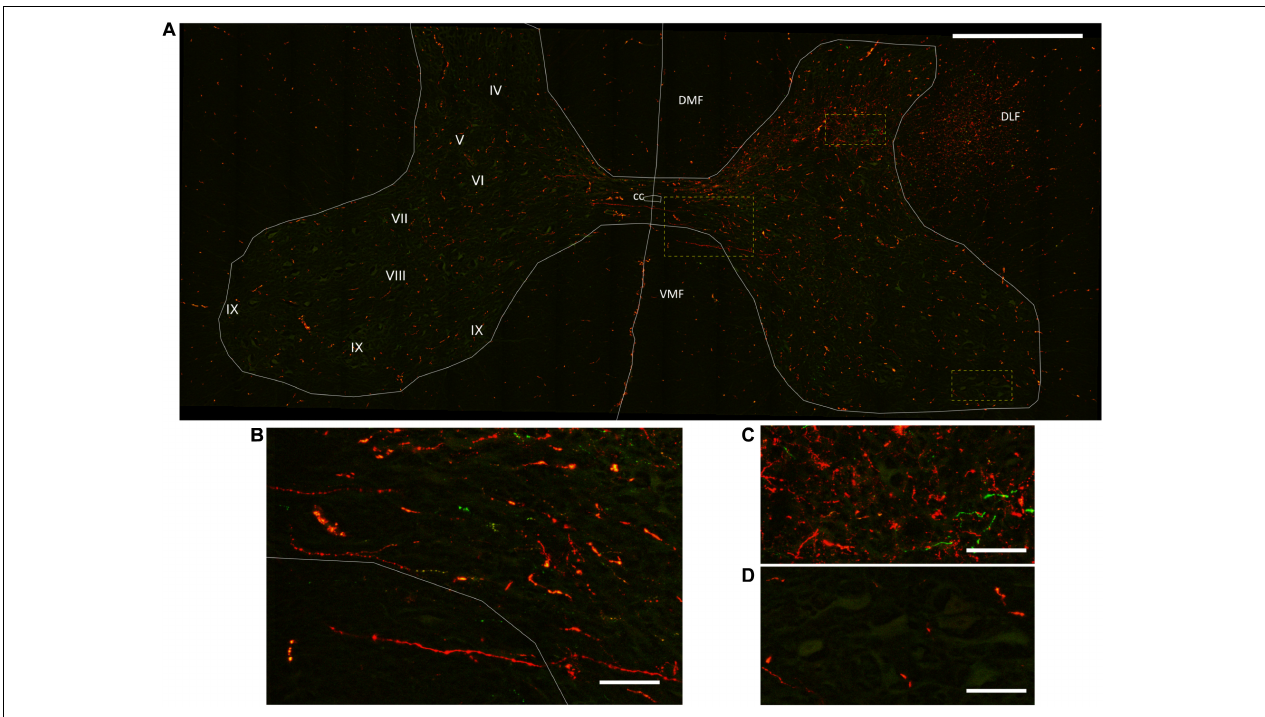
FIGURE 4 | Corticospinal axon distribution in the spinal gray matter laminae. (A) Mosaic of confocal fluorescence images acquired with a 20X objective from a 60- µ m-thick transverse section of the C6 spinal cord segment, illustrating the innervation of the spinal gray matter by corticospinal axons. The gray matter laminae are an approximation from human and rat descriptions (Paxinos and Watson, 1998; Mai and Paxinos, 2012). Scale bar, 1 mm. (B–D) Magnification of the spinal cord regions in the rectangles in A, showing decussating spinal axons (B) , as well as the comparative innervation of the intermediolateral (C) and ventrolateral (D) areas of the gray matter. Scale bar, 100 µ m. DMF, dorsomedial funiculus; DLF, dorsolateral funiculus; VMF, ventromedial funiculus; cc, central